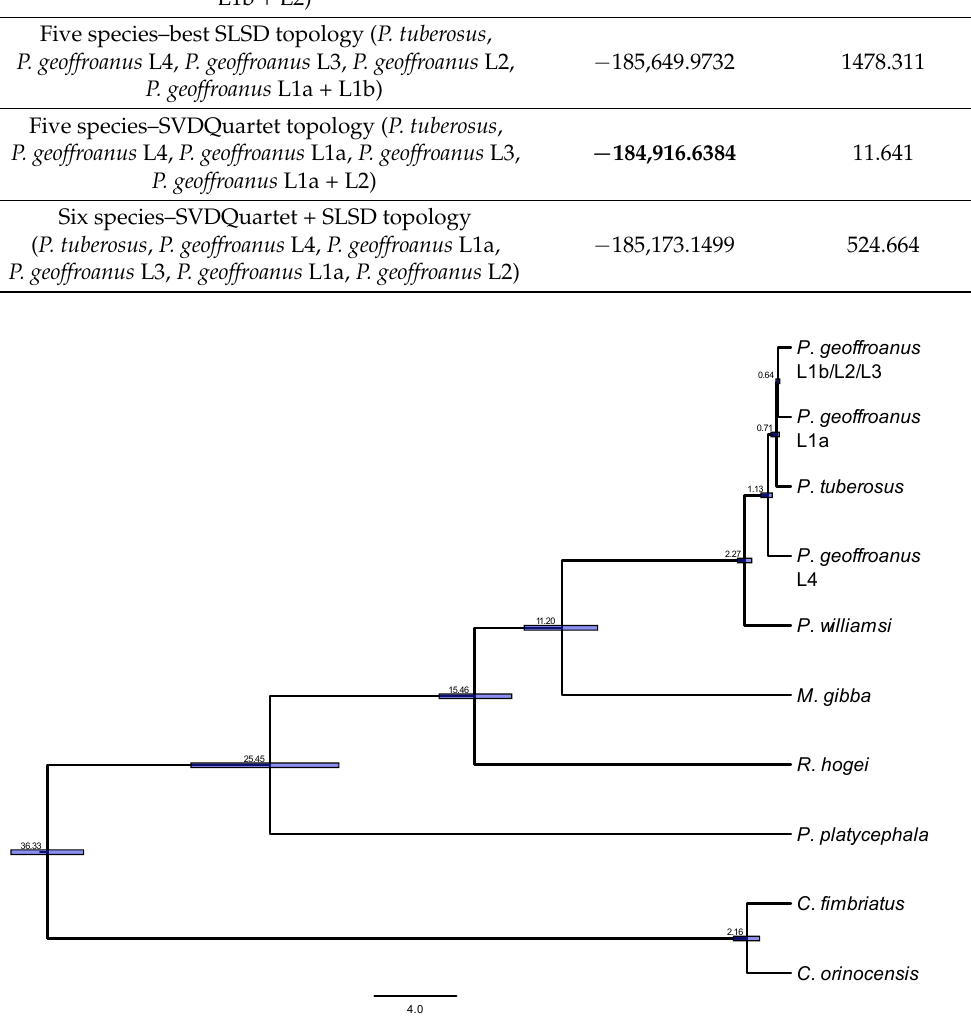
Figure 3. Dated species tree of Chelidae with emphasis on the Phrynops geoffroanus species complex assuming the most likely taxonomic hypothesis ( P. tuberosus , P. geoffroanus L4 coastal Atlantic drainages, P. geoffroanus L1a Paran á basin, P. geoffroanus L3 + L1a + L2 S ã o Francisco + Amazon